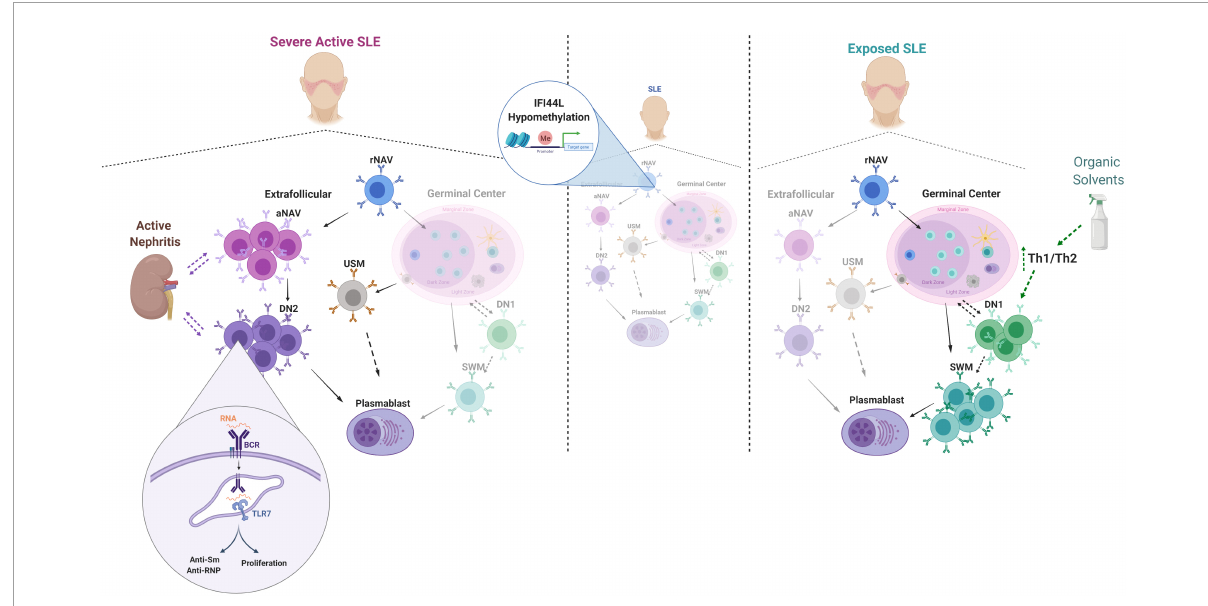
FIGURE6 Summary of main findings and discussion elements. The dotted lines denote possible relationships or trends that require further validation studies. This figure was designed with